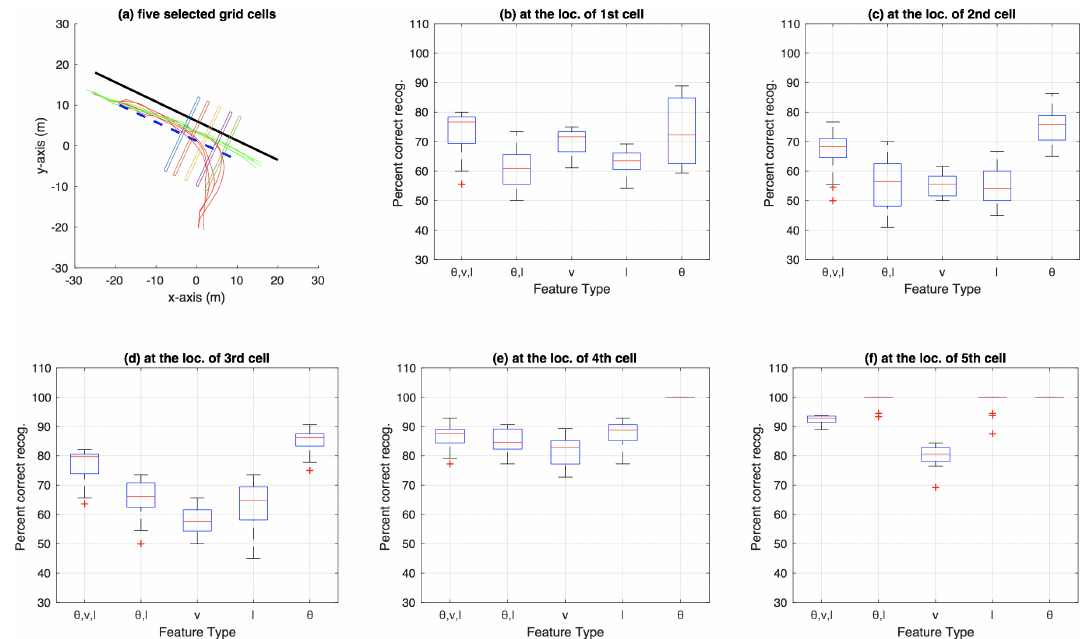
Figure 8. Aggregate results for car-turning dataset using particle filtering: ( a ) the five grid cells show locations where 60%, 70%, 80%, 90%, and 99% of the total car path length (for the path discretised using the grid shown in Figure 1b) has been traversed; and ( b )–( f ) box plots at each of the five grid-cell locations in ( a ). Each subfigure ( b )–( f ) shows a box plot for percentage of correct category recognition for different feature types used including ( θ , v , l ) , ( θ , l ) , v , l and θ